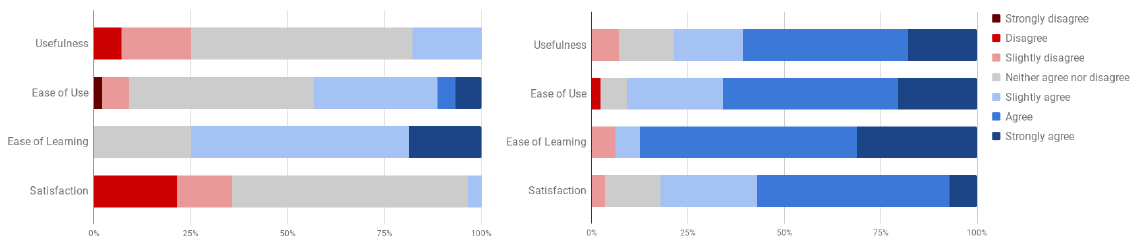
Figure 4. Results of the usefulness, ease of use, ease of learning, and satisfaction questionnaire of Asura: the control group (on the left ) and the treatment group (on the right